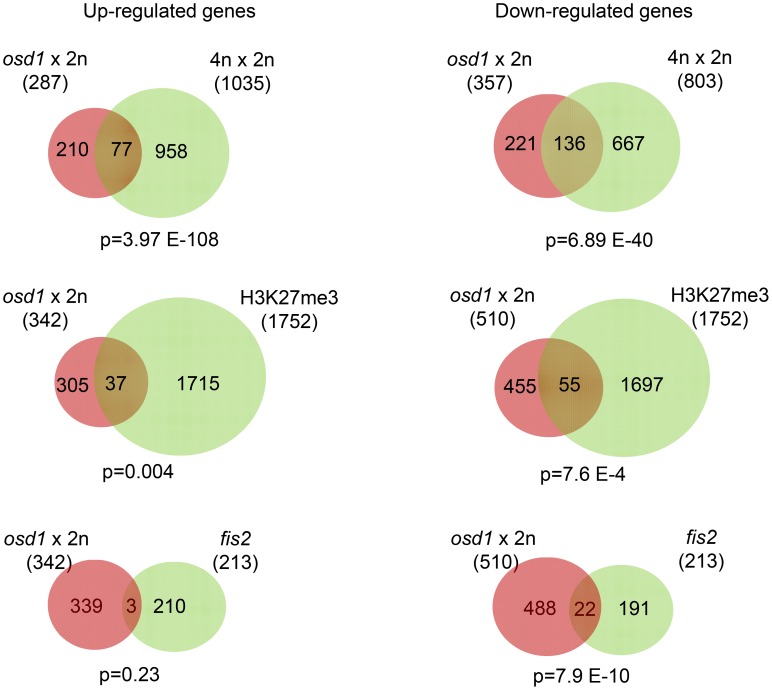
FIS-PRC2 Target Genes Are Deregulated in Response to Maternal Excess Interploidy Hybridizations.Venn diagrams showing overlap of genes being deregulated in seeds derived from osd1×2n crosses with genes deregulated in seeds of 4n×2n crosses [24] (upper panel); overlap of deregulated genes in seeds derived from osd1×2n crosses with H3K27me3 target genes in the endosperm [49] (middle panel), and genes that are upregulated in fis2 mutant seeds [9] (lower panel). In the upper panel only deregulated genes that are present on the ATH1 array have been used to calculate the overlap.